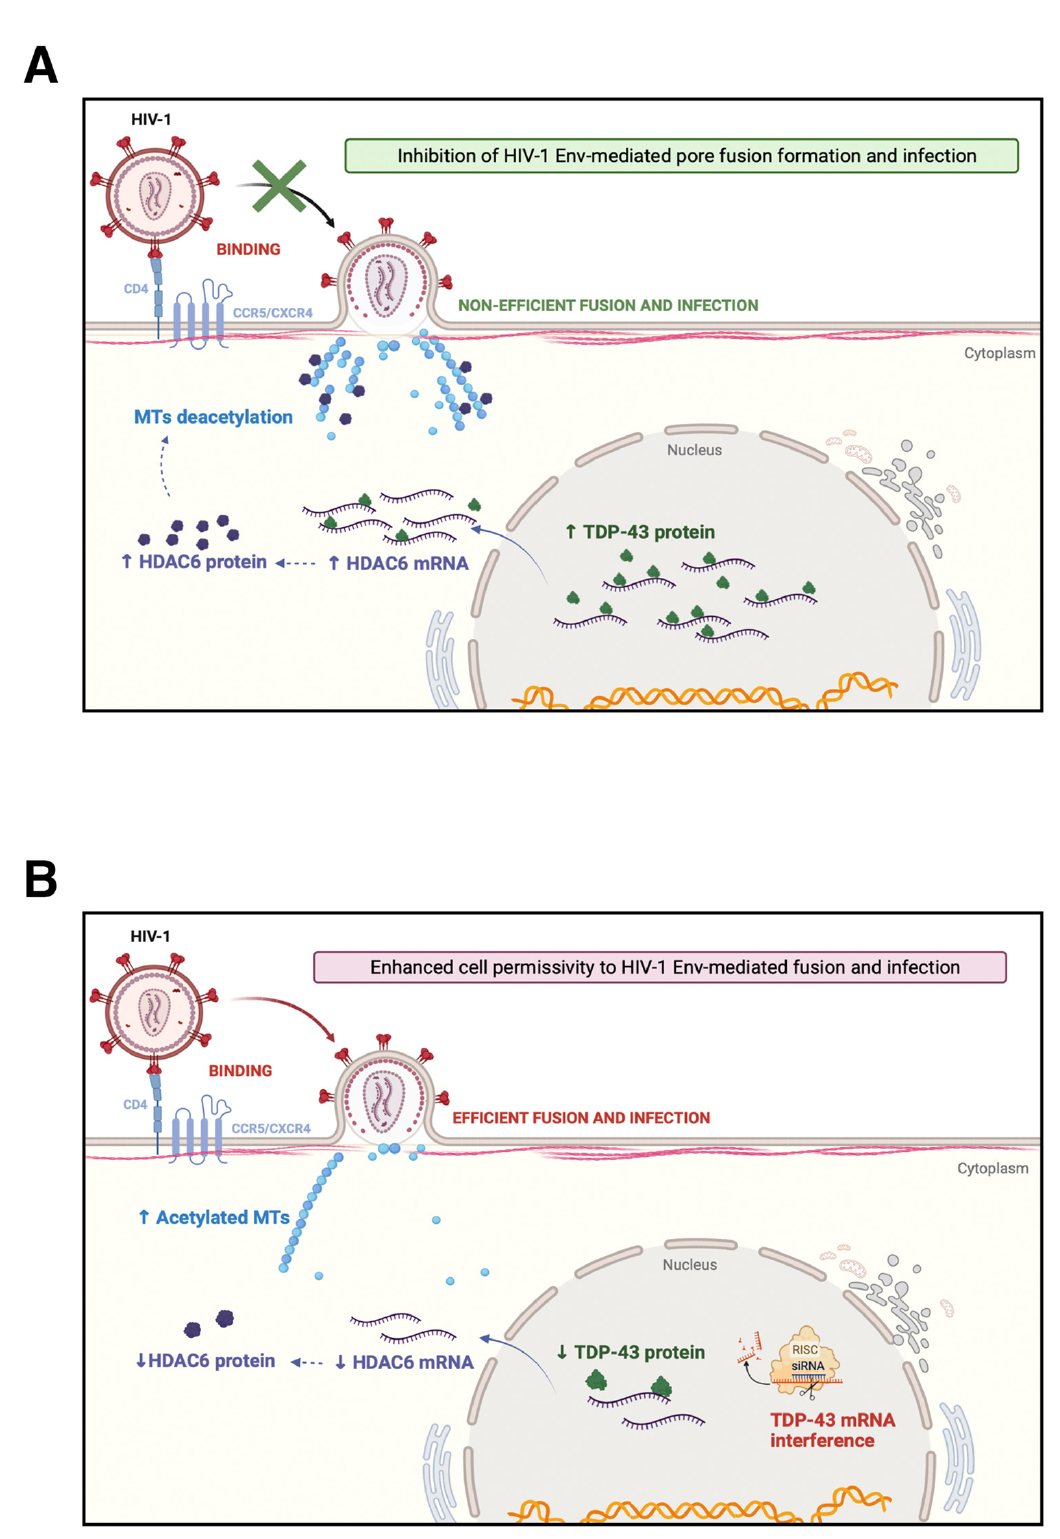
Figure 8. Schematic representation of the regulatory mechanism of CD4+ T-cell permissivity to HIV-1 infection exerted by the TDP-43/HDAC6 axis. ( A ) TDP-43 overexpression increased both mRNA and protein levels of the tubulin-deacetylase HDAC6 enzyme, which led to a decrease in the level of stable acetylated MTs required for efficient HIV-1 Env-mediated pore fusion formation and infection